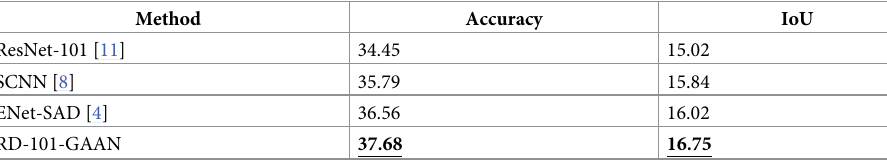
Table 9. Evaluation of GAAN in BDD100K.